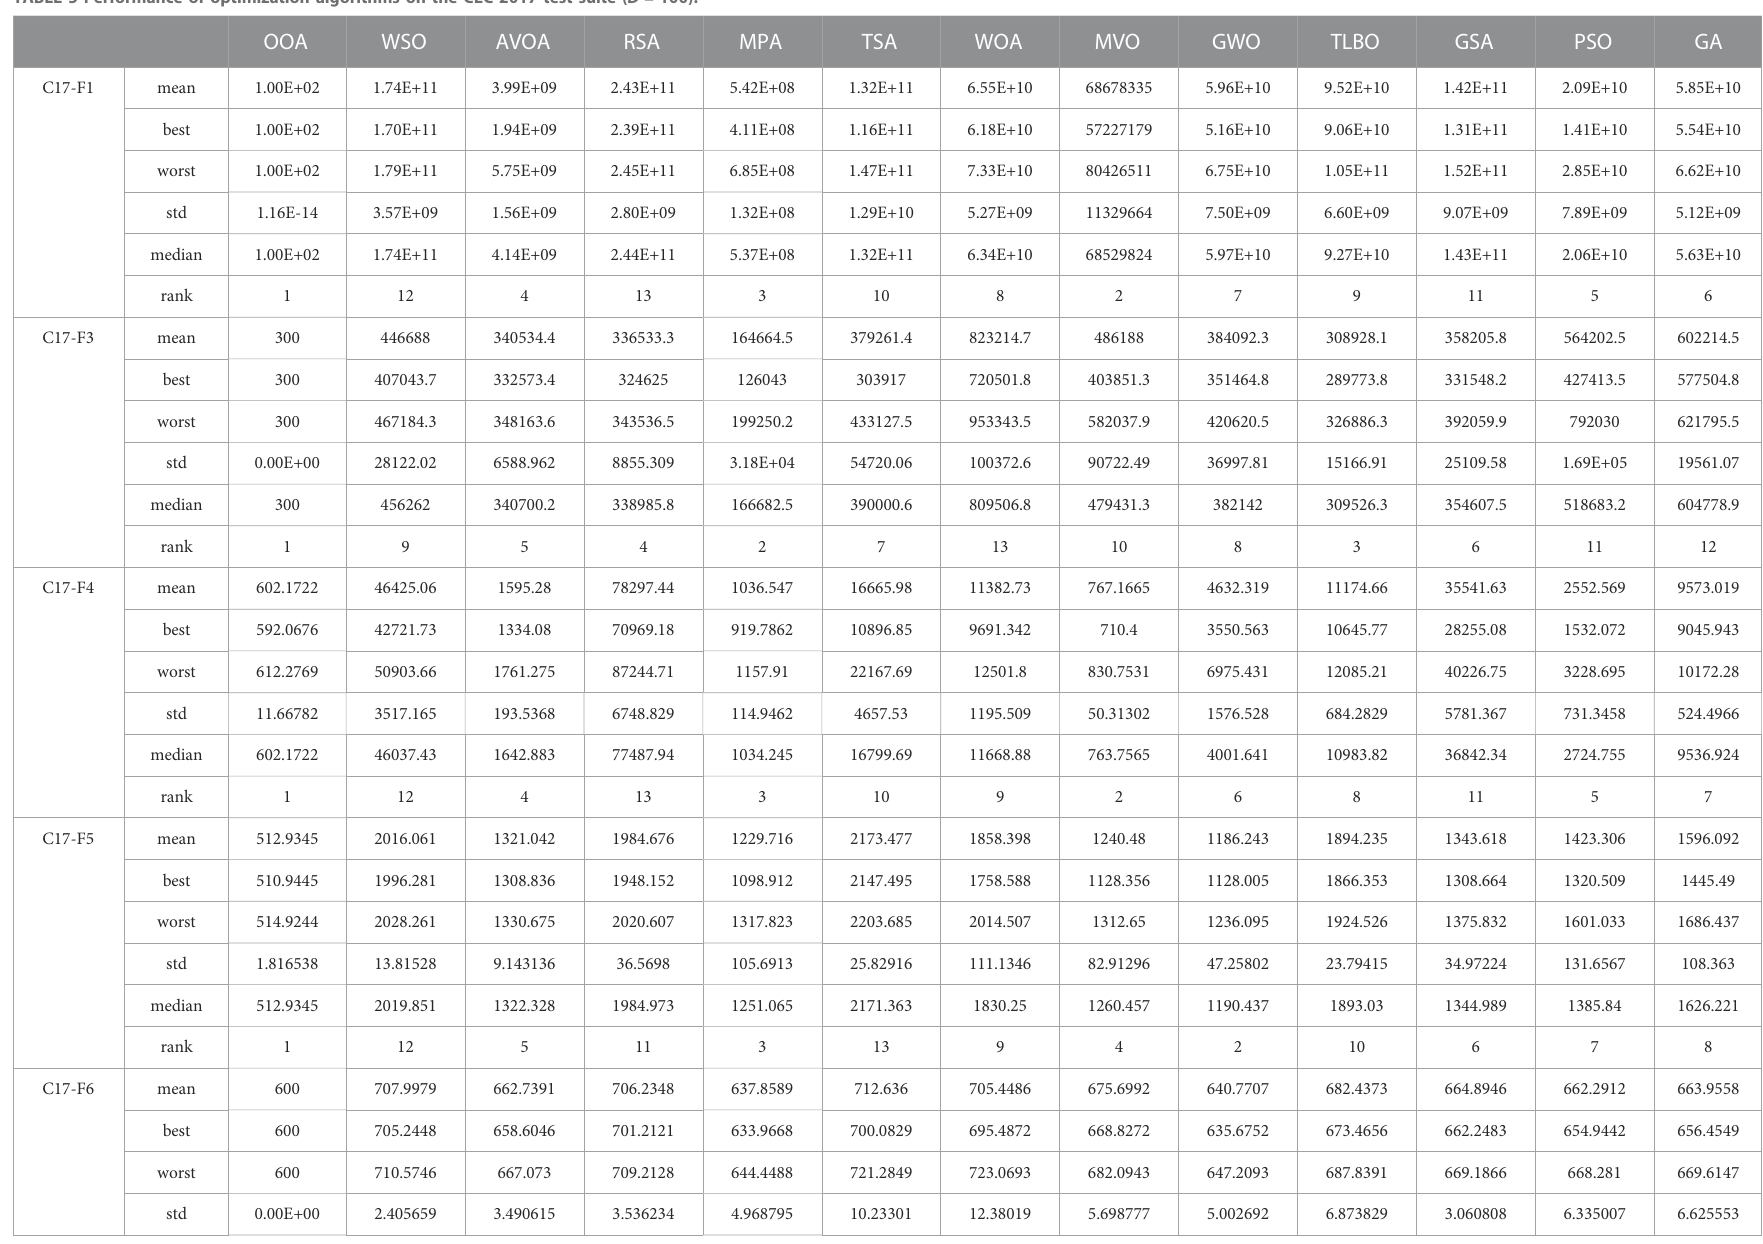
TABLE 5 Performance of optimization algorithms on the CEC 2017 test suite ( D (cid:1)